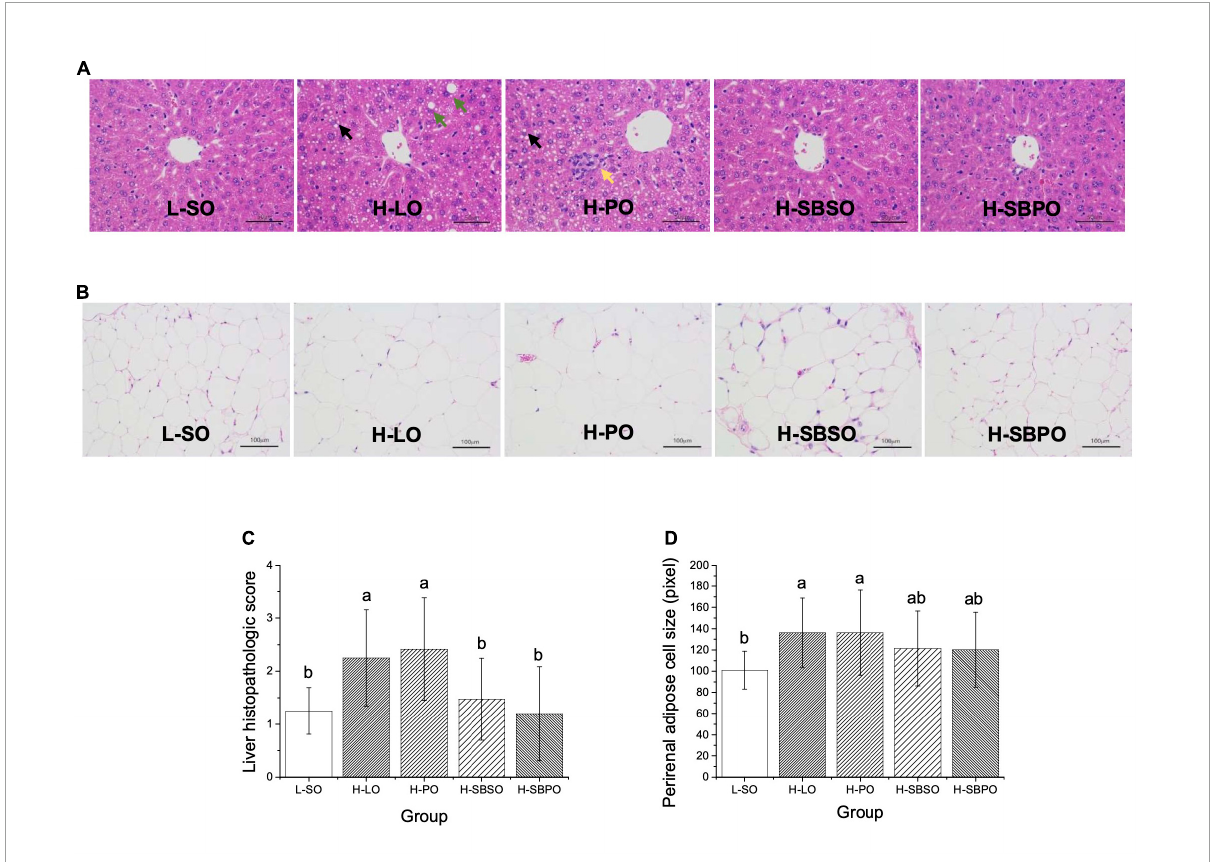
FIGURE3 Representative images of H&E staining of (A) liver (enlarged 400 × ), (B) perirenal fat (enlarged 200 × ), (C) liver histopathologic scores, and (D) perirenal adipose cell sizes of mice treated with L-SO, H-LO, H-PO, H-SBSO, or H-SBPO ( n = 12). L-SO, low-fat diet with soybean oil; H-LO, high-fat diet with lard oil; H-PO, high-fat diet with peanut oil; H-SBSO, high-fat diet with sea buckthorn seed oil; H-SBPO, high-fat diet with sea buckthorn pulp oil. Black arrows indicate various sizes of circular vacuoles detected in the cytoplasm; green arrows indicate the fusion of large lipid droplets in the cytoplasm; while the yellow arrow indicates the focal infiltration of lymphocytes. Different letters (a and b) indicate significant differences ( P < 0.05) in mice liver pathological score and perirenal adipose cell size between each other.